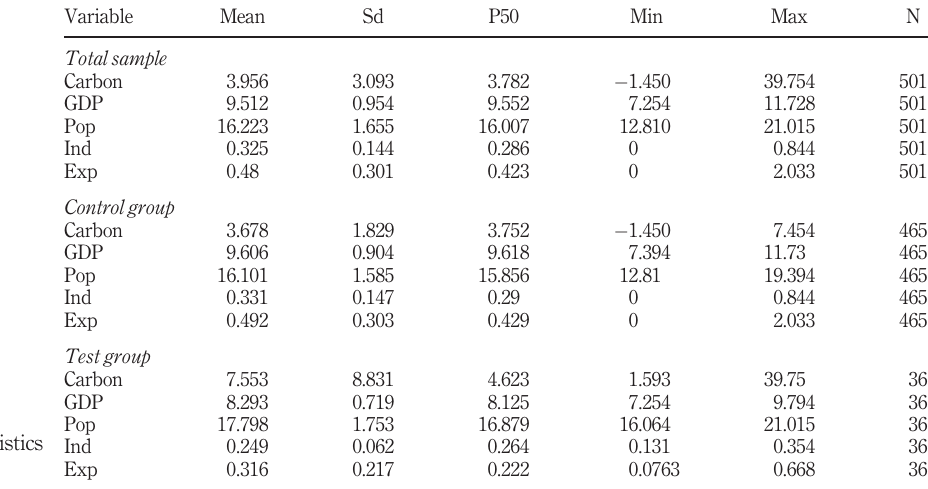
Table II. Descriptive statistics